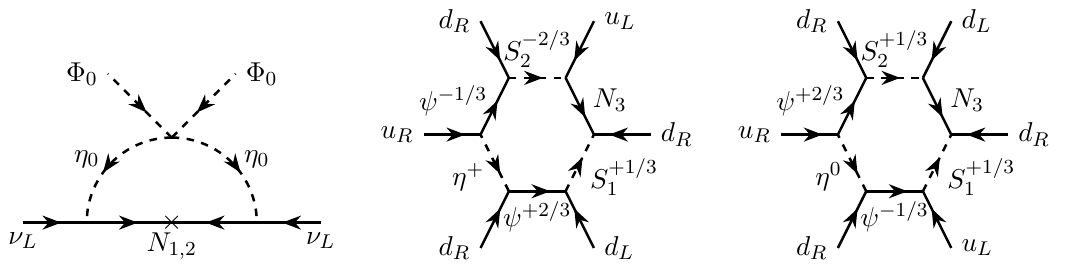
Figure 5 . The Feynman diagrams of neutrino mass (left) and neutron-antineutron oscillation (middle and right) in the example